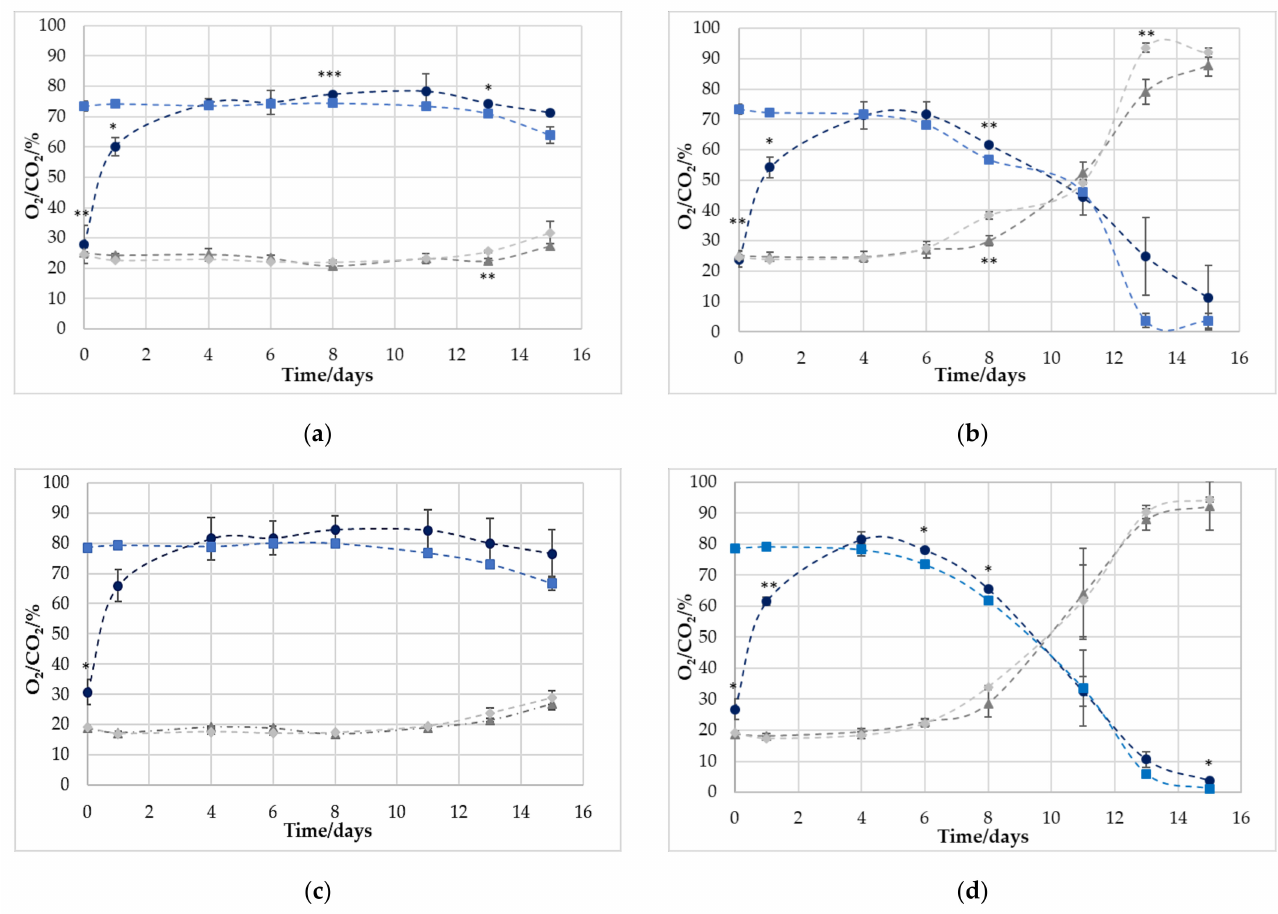
Figure 2. Comparison between the destructive ( (cid:4) / (cid:7) ) and non-destructive ( • / (cid:78) ) measurement devices for the investigation of O 2 ( (cid:4) / • ) and CO 2 ( (cid:7) / (cid:78) ) during the storage of poultry over 15 days under different storage conditions: ( a ) 70% O 2 /30% CO 2 4 ◦ C ( b ) 70% O 2 /30% CO 2 10 ◦ C ( c ) 80% O 2 /20% CO 2 4 ◦ C ( d ) 80% O 2 /20% CO 2 10 ◦ C. Indices indicate a significant difference be- tween the curves measured with the destructive and non-destructive measurement devices: * p < 0.05, ** p < 0.01, and *** p <